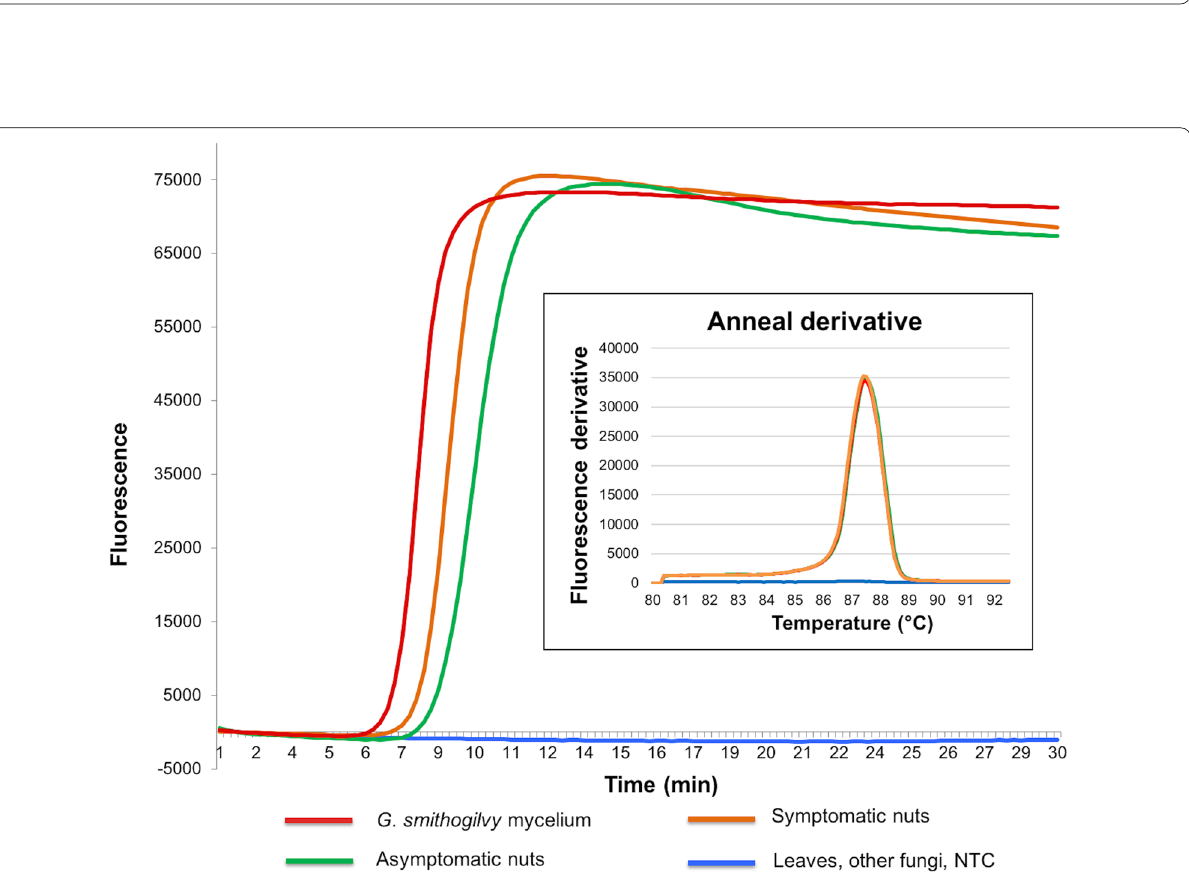
Fig. 2 Portable LAMP (P-LAMP) by Genie II to detect Gnomoniopsis smithogilvyi DNA in symptomatic and asymptomatic nuts in comparison with fungal mycelium. The insert shows the specific G. smithogilvyi melting peak (T a